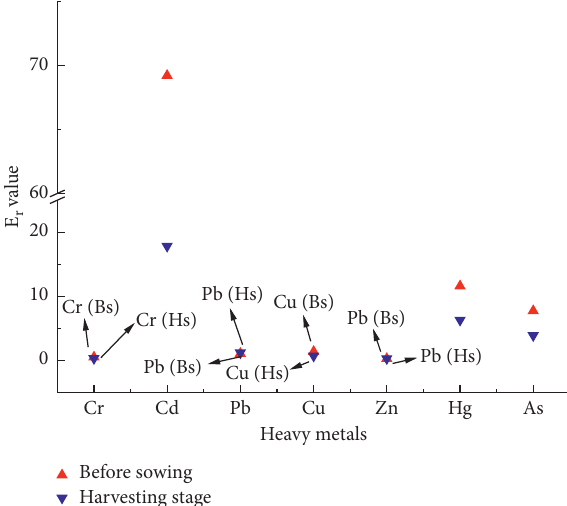
Figure 3: E i r values of heavy metals in soil at the two growth periods of